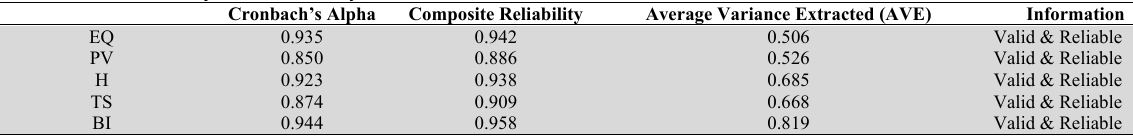
The Results of Validity and Reliability